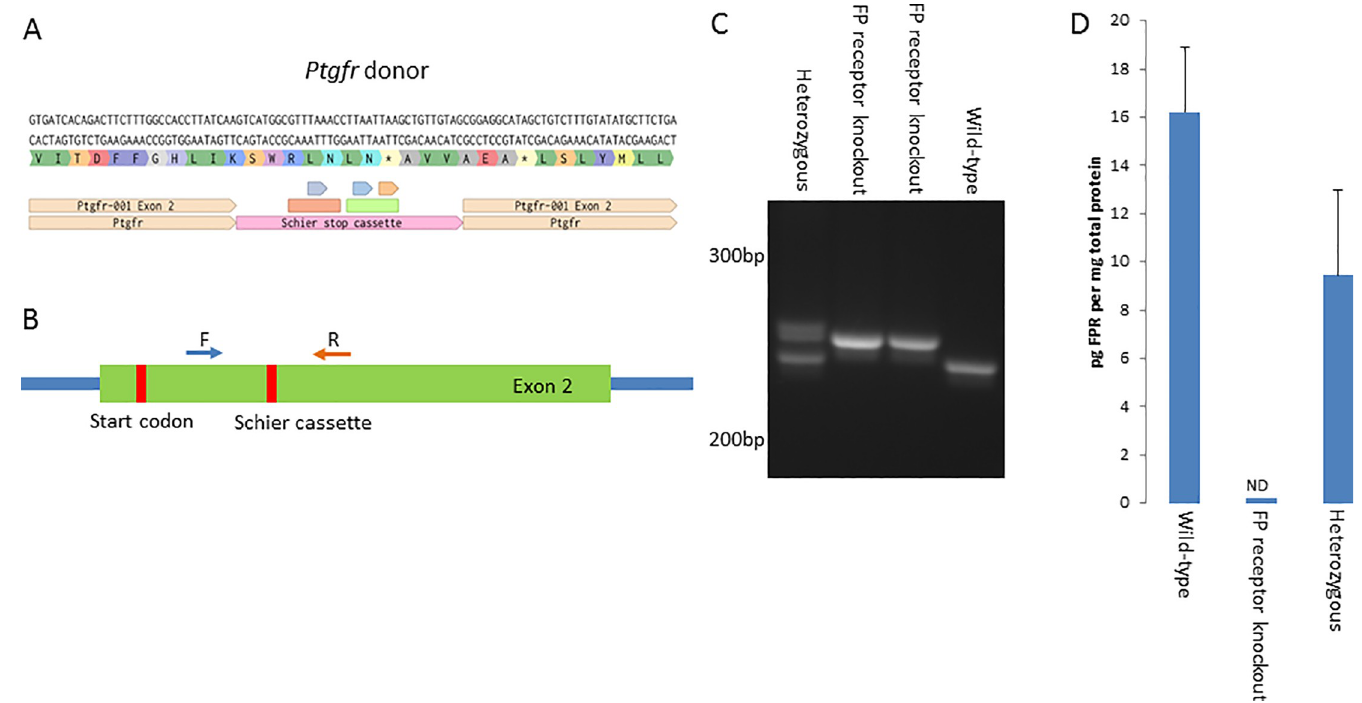
Fig 3. Generation of FP receptor knockout mice. A) Schematic representing strategy of Schier stop cassette insertion, single-guide RNA (sgRNA), WT Cas9 mRNA and a single-strand DNA (ssDNA) donor into the cytoplasm of C57BL/6NHsd zygotes. The ssDNA donors contained stop codons in all three reading frames to ensure a premature stop when inserted. B) Schematic representing Shier stop cassette. C) Genotyping data confirms insertion of the Schier stop cassette. D) ELISA in uterine tissue revealed diminished FP receptor expression at the protein level in mice heterozygous for the FP receptor compared to wild-type and non-detectible FP receptor expression in FP receptor knockout mice. ND = not detected. Error bars represent average ± standard deviation.